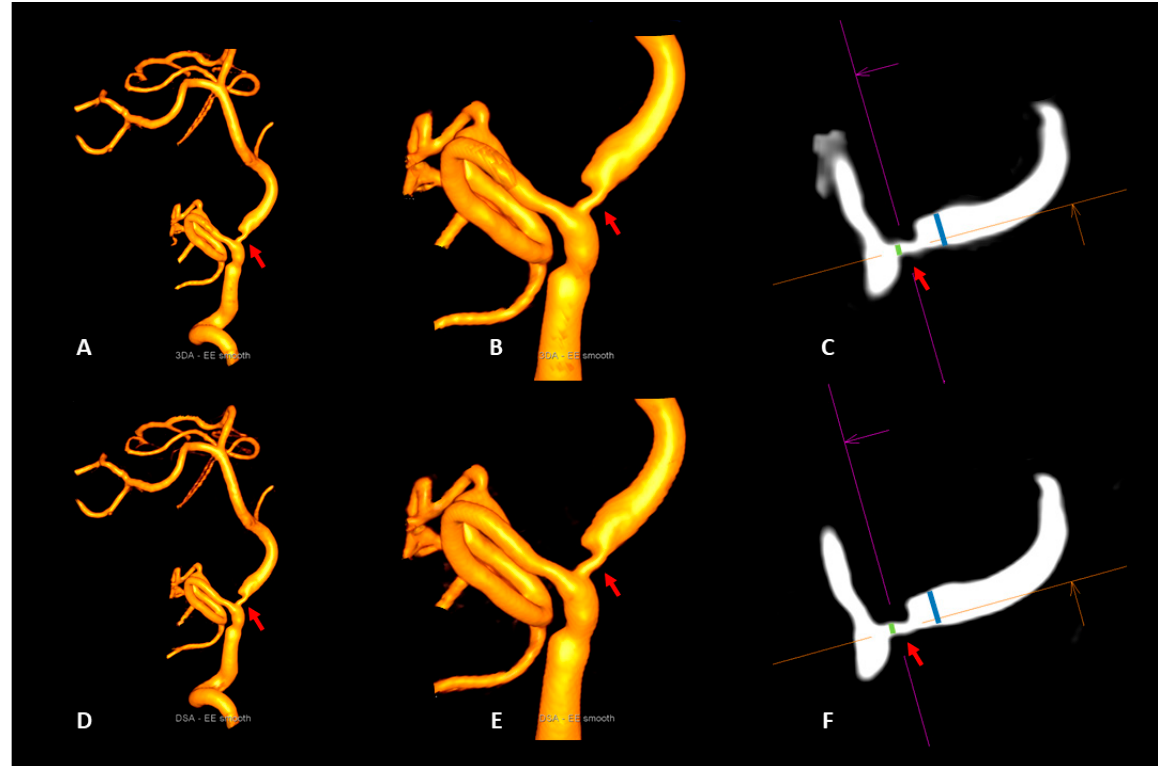
Figure 2. Illustrative case 1. Visualization of a vertebrobasilar stenosis (red arrows) with the artificial intelligence-based 3DA ( A – C ) and 3D-DSA ( D – F ). 3DA ( A , B ) provides a 3D-DSA ( D , E ) comparable visibility of the stenotic segment (red arrows) in the volume-rendered reconstructions. Due to the high level of correspondence of the measurements of the intra- and poststenotic diameters in multiplanar reconstructions of 3DA ( C ) and 3D-DSA ( F ), the calculation of the percentual degree of luminal restriction revealed a 64% stenosis of the vertebrobasilar junction for both reconstruction types (NASCET 3DA = 63.9%; NASCET 3D-DSA = 63.6%).